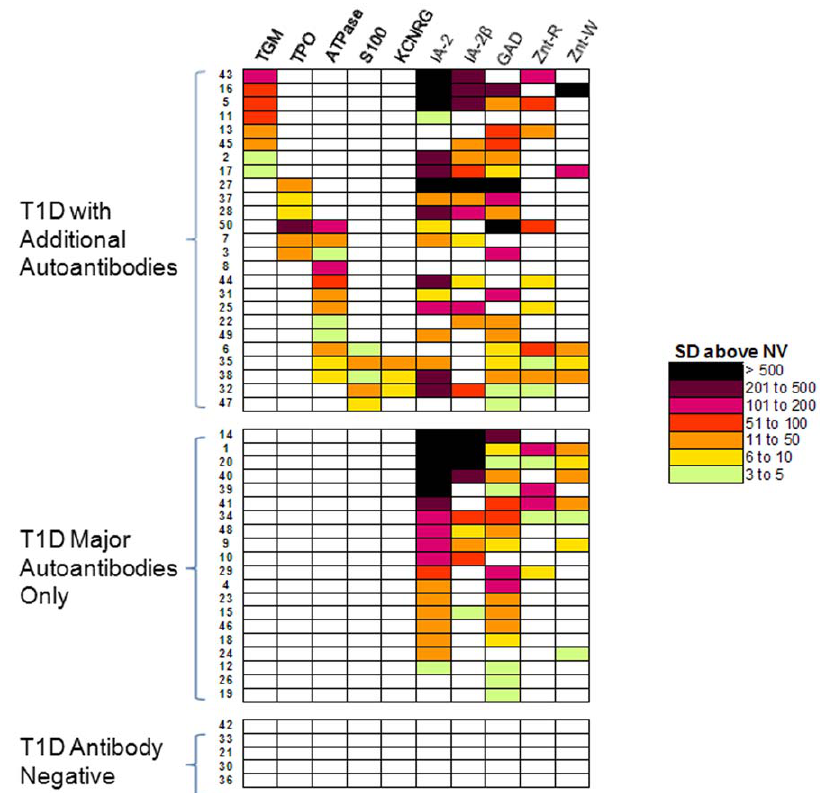
Figure 3. Autoantibody portraits in T1D subjects. Individual autoantibody titers in the 50 T1D subjects from the DASP 2010 cohort are presented as a heatmap. As described in the material and methods, color code reflects the relative titers in standard deviations above the mean plus three SD of the control subjects for each of the 10 antibody-antigen pairs. Individual antibody profiles were then manually assembled based on the presence or absence of particular organ-specific autoantibodies and then by autoantibodies to the major islet autoantigens.